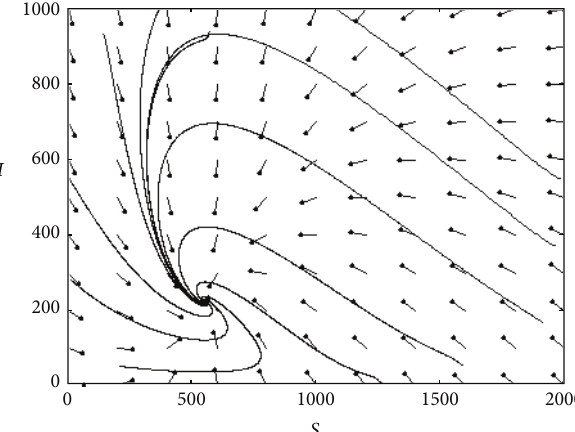
Figure 2: Phase plot of 𝐼 verses 𝑆 showing stability of unique endemic equilibrium pointwhen 𝑅 0 > 1 and 𝛿 > 1 fortheparameter values 𝑏 1 = 80 , 𝜆 1 = 0.0004 , 𝛼 = 0.04 , 𝜇 1 = 0.06 , 𝛾 = 0.015 , 𝜆 2 = = 200 , 𝜇 = 0.5 . 0.0002 , 𝑏 2 2